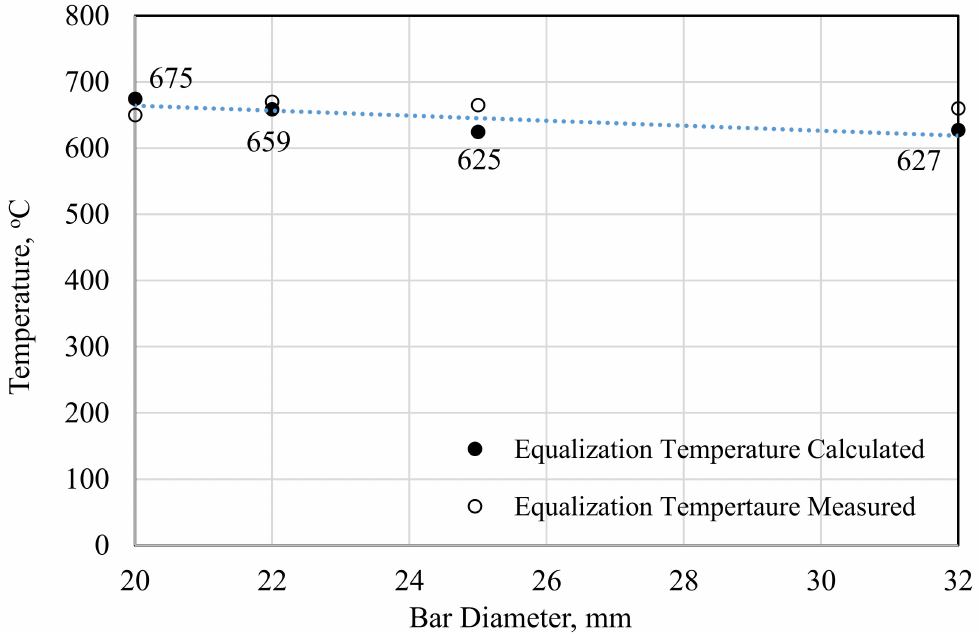
Figure 11. Equalization temperature after self-tempering process: 4 diameters, 20, 22, 25, and 32 mm rebars are industrially produced, but onle two rebars (20, and 32 mm) are represented in this